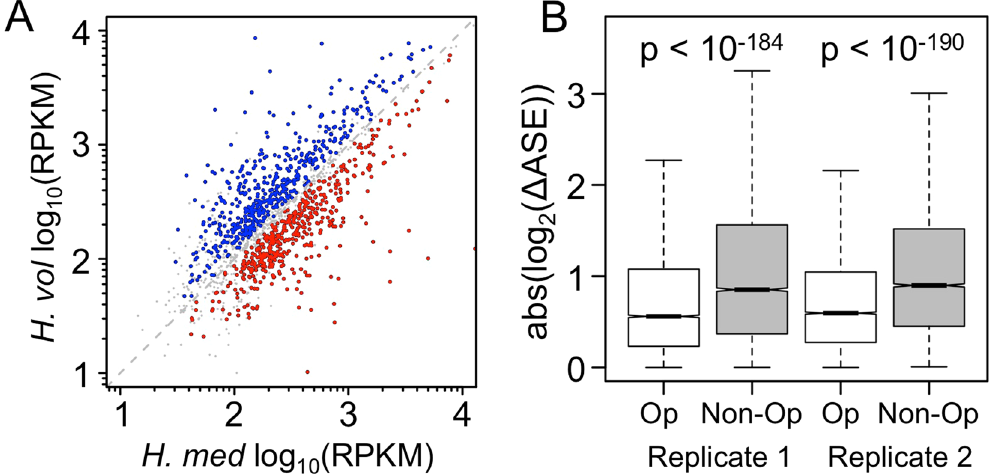
Figure 2. Regulatory divergence between archaeal hybrids is revealed by ASE analysis. ( A ) Approximately equal numbers of orthologs show significant allelic bias favoring either the H . mediterranei (453, red) or H . volcanii allele (476, blue) (see Methods and Supplementary Fig. 4). RPKMs plotted in this figure are the mean of the two biological replicates after normalization. med, mediterranei; vol, volcanii. ( B ) Pairwise